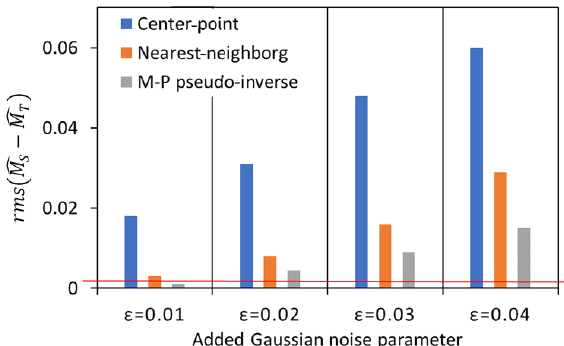
Fig. 5. Errors estimated in the numerical simulations for air, using three different strategies to compute the Mueller matrices, and experimental results for the